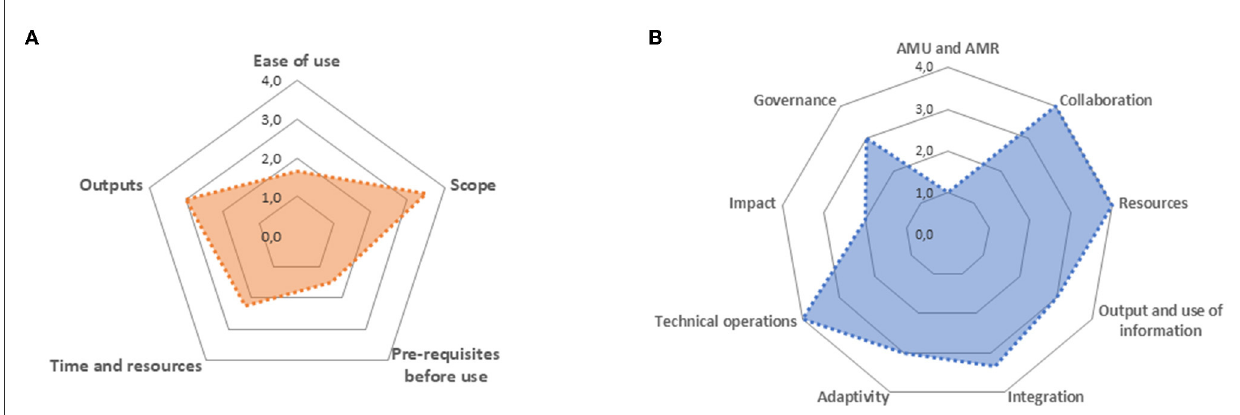
FIGURE1 Radar diagrams depicting graphically the scoring of the functional aspects (A) and the content themes (B) , based upon a French case study using ECoSur. Source: